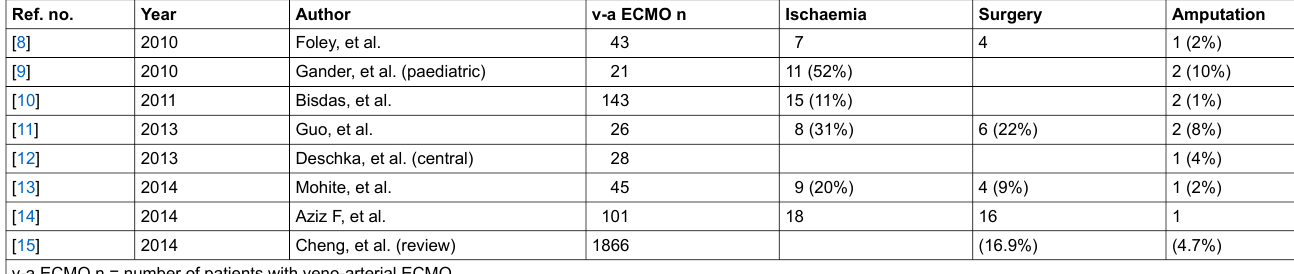
v-a ECMO n = number of patients with veno-arterial ECMO Ischaemia = number of patients (%) with lower extremity ischaemia Surgery = number of patients (%) requiring surgery for lower extremity ischaemia Amputation = number of patients (%) requiring lower extremity amputation Note: n and (%) values given are cited from the references